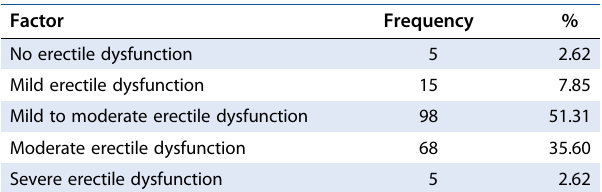
Table 3: Scoring of erectile dysfunction in frequency and